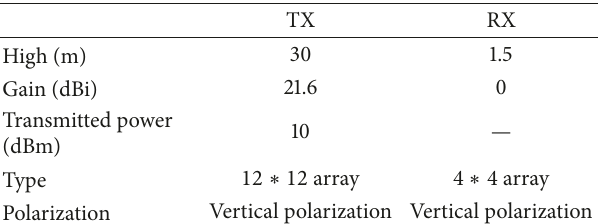
Table 1: TX/RX parameters. Table 2: Materials property parameters.